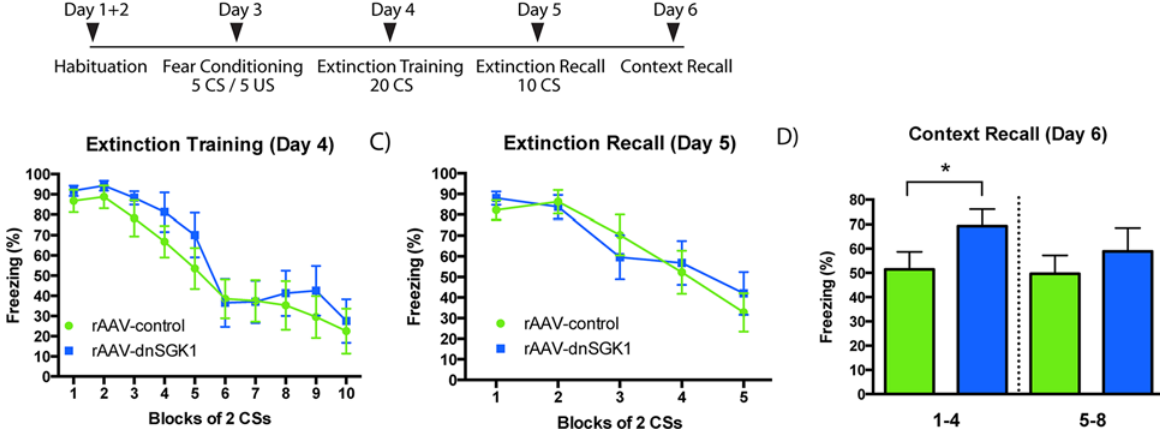
Fig 4. Influence of viral expression of dnSGK1 on contextual memory recall. (A) Rats were infused with rAAV-dnSGK1 or rAAV-EGFP into the mPFC. Four weeks post infusion rats underwent auditory fear conditioning and then extinction training and testing according to the timeline schedule shown. (B) During extinction training, CS-elicited freezing was comparable between the dnSGK1 and EGFP groups (effect for group F(1,18) = 0.7033, p = 0.4127; for trial F(9,162) = 23.15, p < 0.0001; interaction F(9,162) = 0.3374, p = 0.9613, two-way repeated measures ANOVA). (C) During extinction recall, there was no significant difference in freezing between dnSGK1 and controls (effect for group F(1,18) = 0.01975, p = 0.8898; for trial F(4,72) = 20.27, p < 0.0001; interaction F(4,72) = 0.7638, p = 0.5523, two-way repeated measures ANOVA). (D) When reexposed to the original context, rats infused with dnSGK1 showed significantly higher freezing during the first 4 min of testing (t(18) = 1.787, one-tailed Student ’ s t test, * p < 0.05), but not during the second 4-min block. For underlying data, see S1 Data.